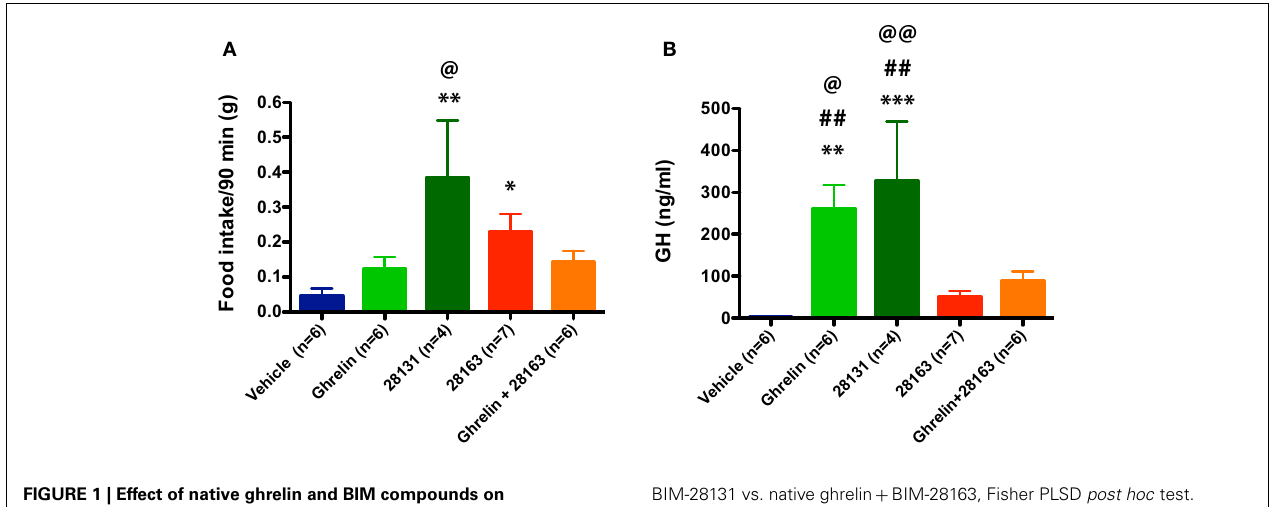
FIGURE 1 | Effect of native ghrelin and BIM compounds on cumulative food intake and GH secretion measured during the light cycle in mice. Data represent mean ± SEM. (A) Mean cumulative food intake (90min) after ip injection of native ghrelin (30nmol), BIM-28131 (30nmol), BIM-28163 (150nmol), and native ghrelin (30nmol) co-administered with BIM-28163 (150nmol). ANOVA shows an effect of treatment on 90min food intake: * p < 0.05 BIM-28163 vs. vehicle, ** P < 0.01 BIM-28131 vs. vehicle, and native ghrelin, @ P < 0.05